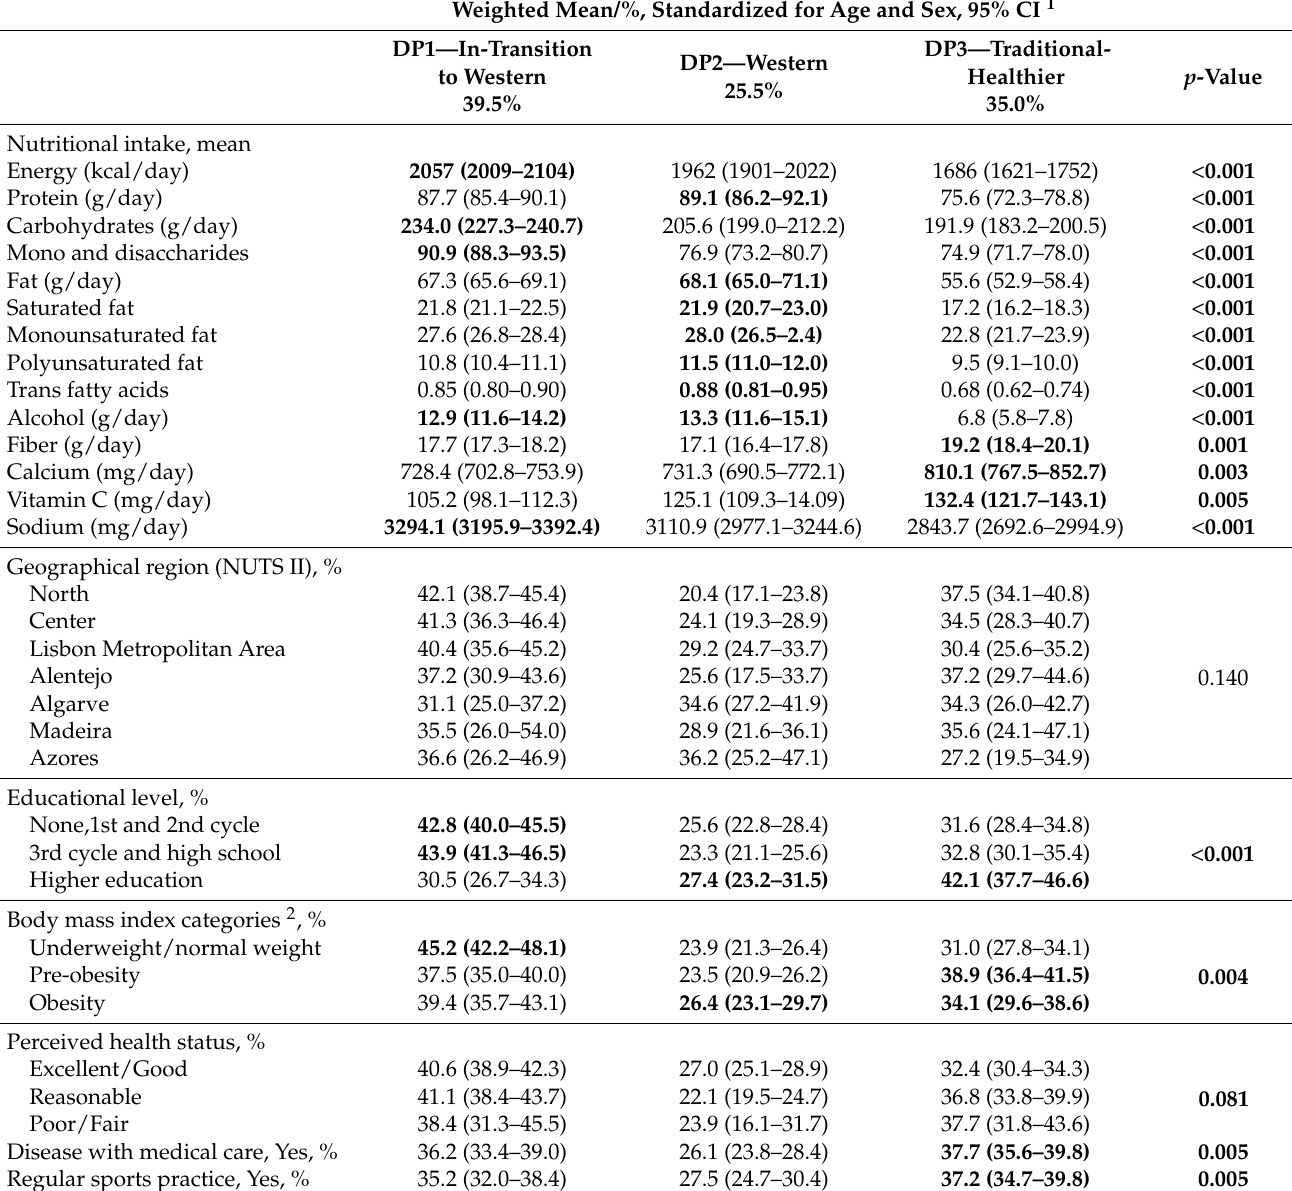
Table 3. Dietary patterns (DPs) derived by the latent transition model with age and sex as concomitant variables, according to nutritional intake, geographical region, socioeconomic, and health